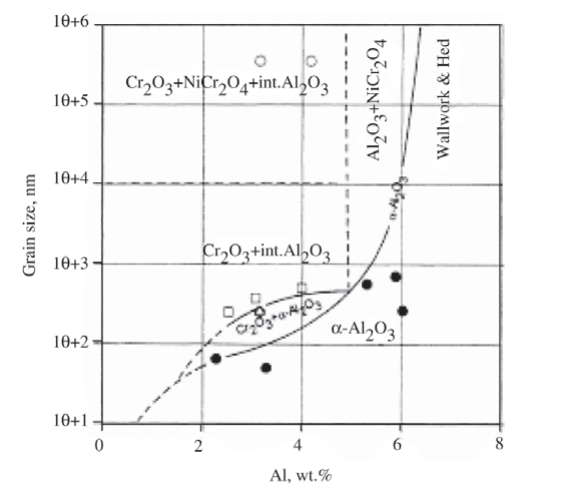
Figure 12 . Oxidation mass gains versus time for Ni-20Cr-3Al, as- cast alloy (grain size ~0.4 mm), coating A (~50 nm) and coating B (~0.5 µ